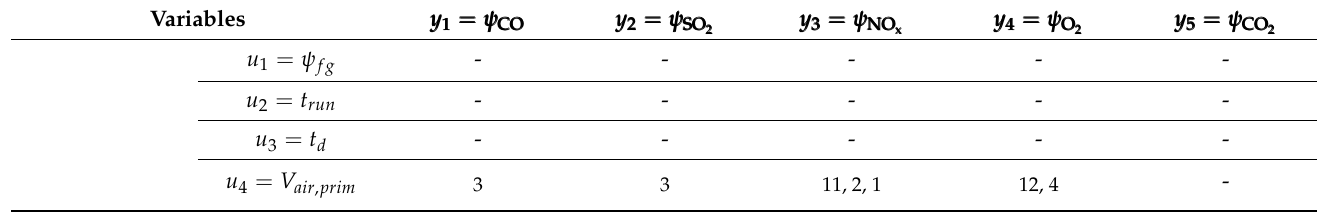
Table 4. Table of state vectors x i for outputs y i (listed in columns) proposed by Boruta Feature Selection Algorithm for sampling period ∆ T s = 10 s. Features u 1 , u 2 , u 3 were not picked by BFSA at all, u 4 is not chosen for y 5 and u 7 is not included in state vector for y 2